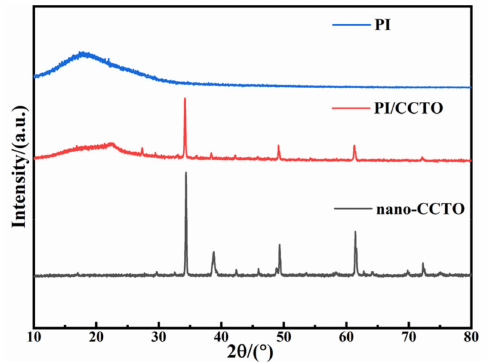
Figure 3. XRD patterns of pure PI, the PI/CCTO composite film and